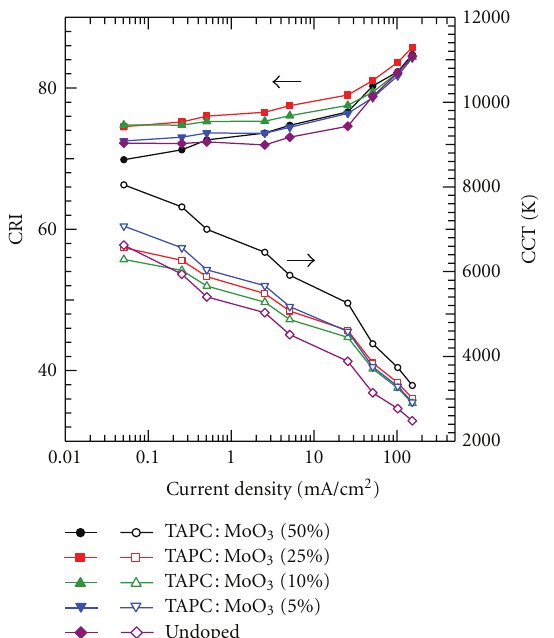
Figure 7: CRI and CCT of WOLEDs with di ff erent MoO 3 doping concentrations as a function of current